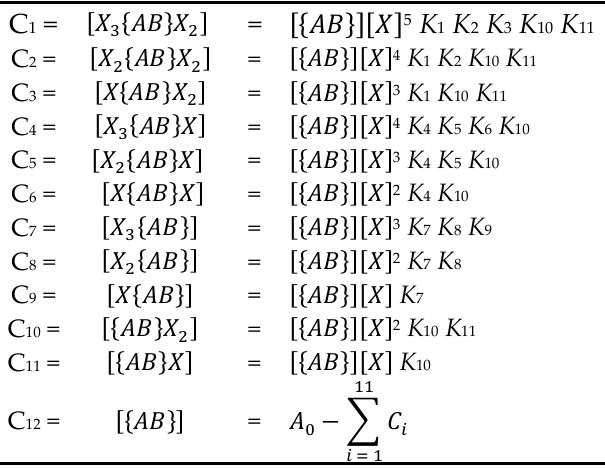
Table 2. Concentrations C i , calculated based on the equilibria in Table 1 and Equation (1); see appendix. C 1